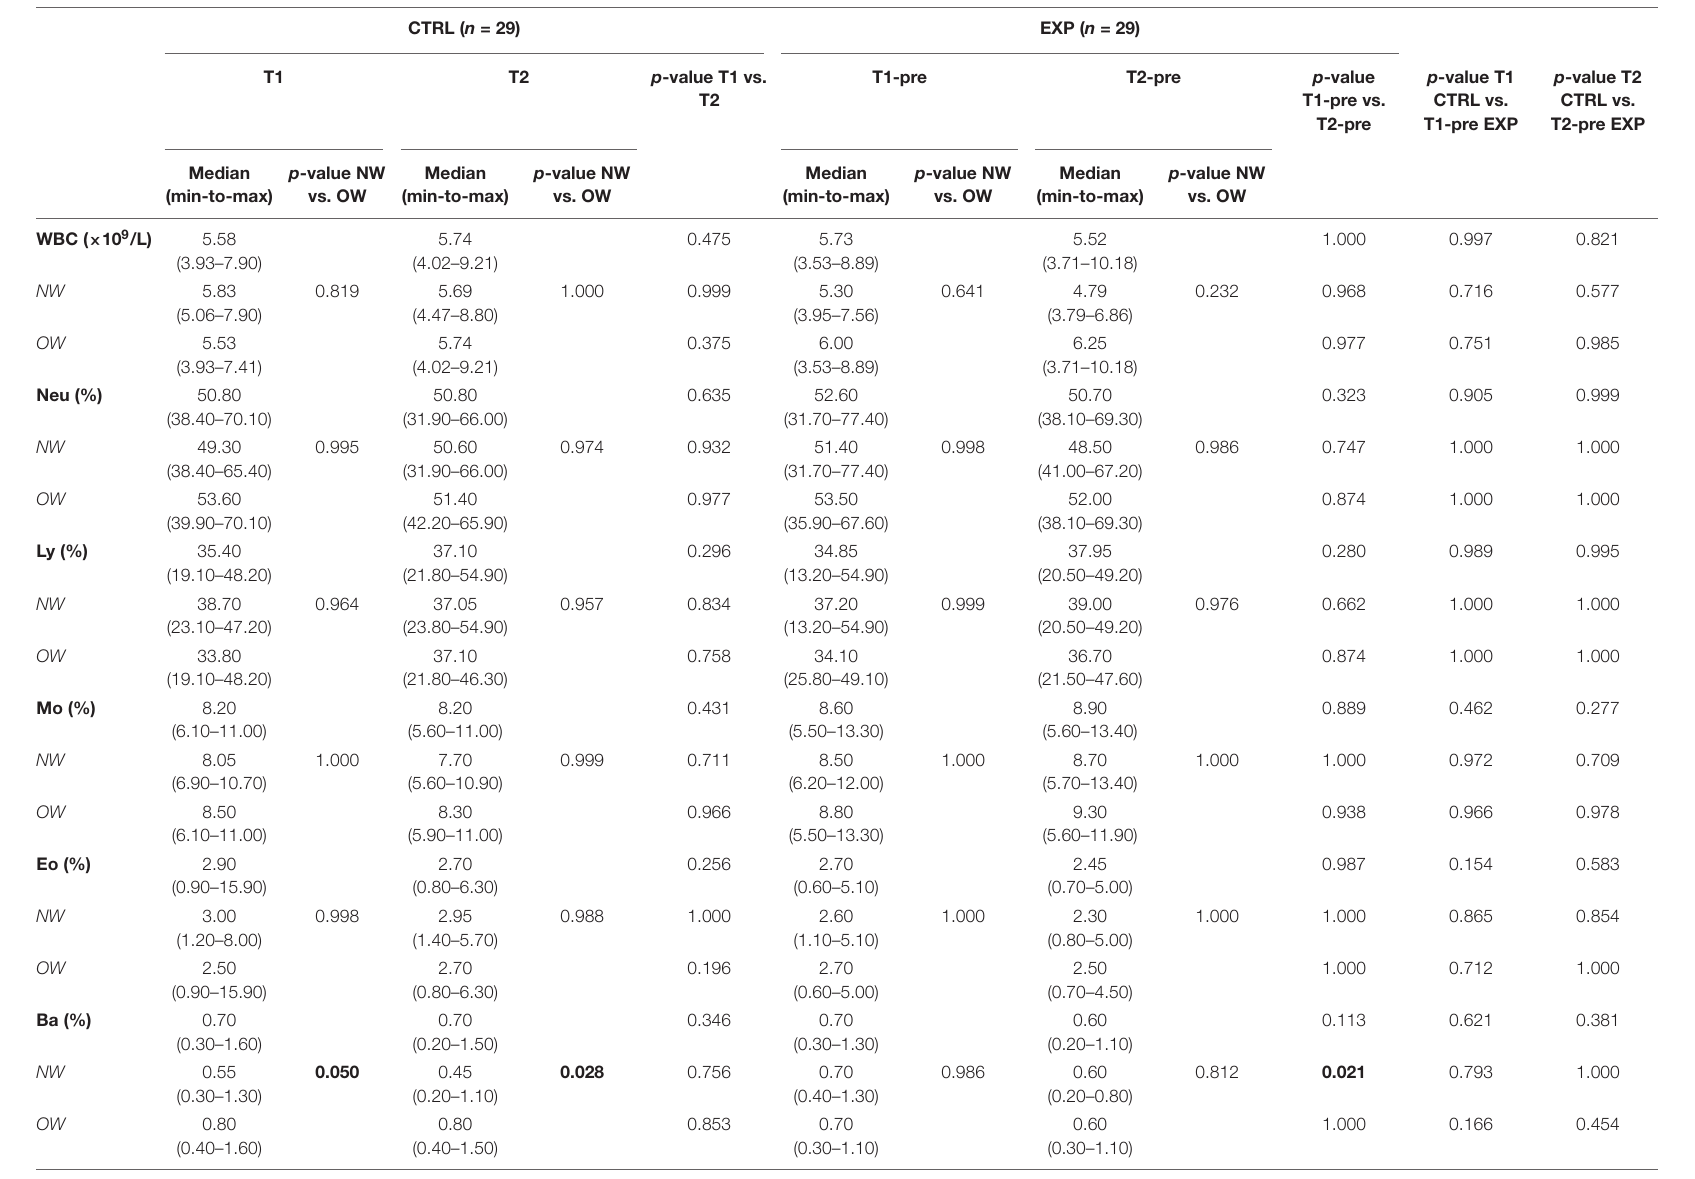
TABLE 2 | White blood cell